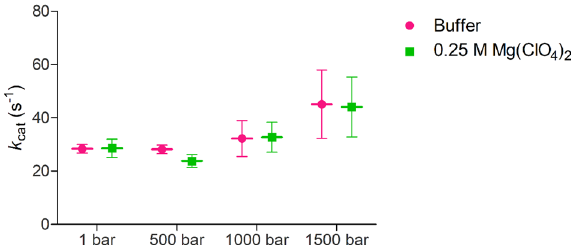
Figure 3. High pressure activity of α-chymotrypsin across pressure at 279 K. The high pressure enzyme activity of α-chymotrypsin expressed as k cat at 279 K (6 °C) in buffer (pink) and in buffer containing 0.25 M Mg(ClO 4 ) 2 (orange). N = 4 and error bars represent the standard error of the